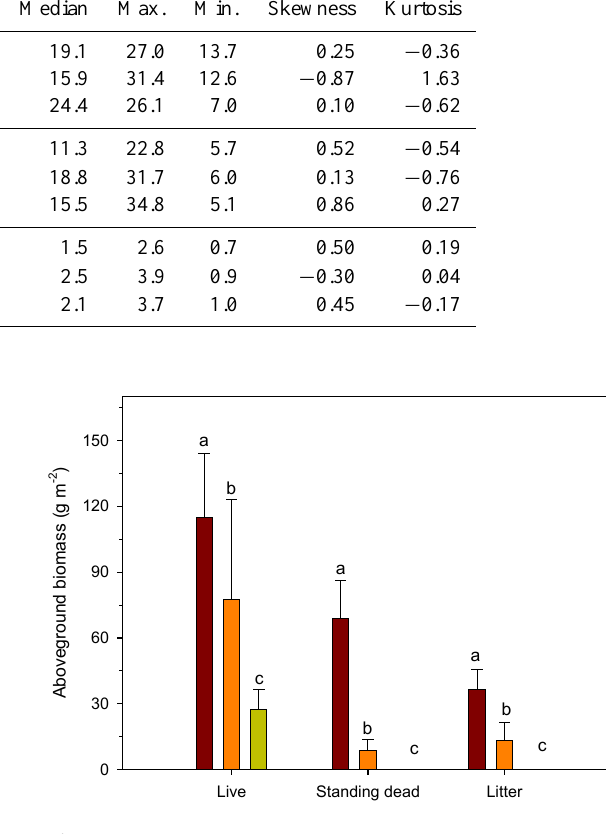
Figure 3. Aboveground biomass at sites exposed to three grazing in- tensities (UG–ungrazed, MG–moderate grazing, HG–heavy graz- ing). Different letters mean significance at P<